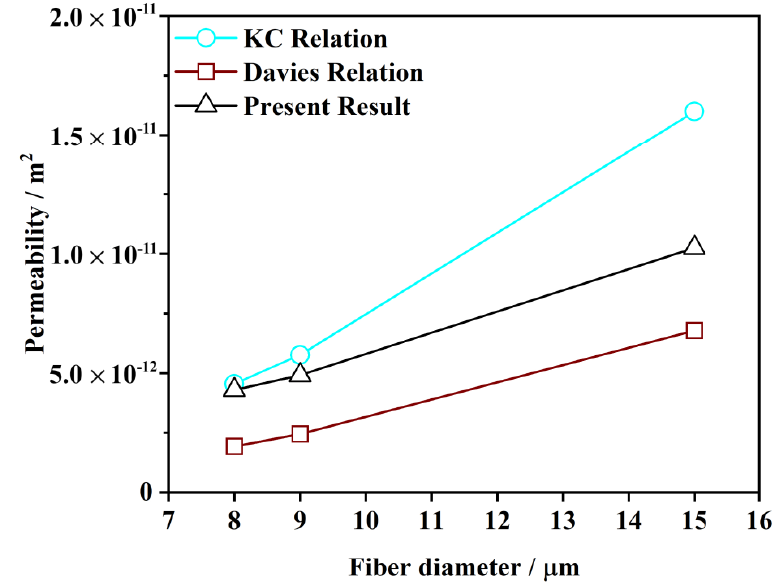
Figure 6. Comparison of the effect of fiber diameter on permeability using the KC relation, the Davies relation and the simulated result.